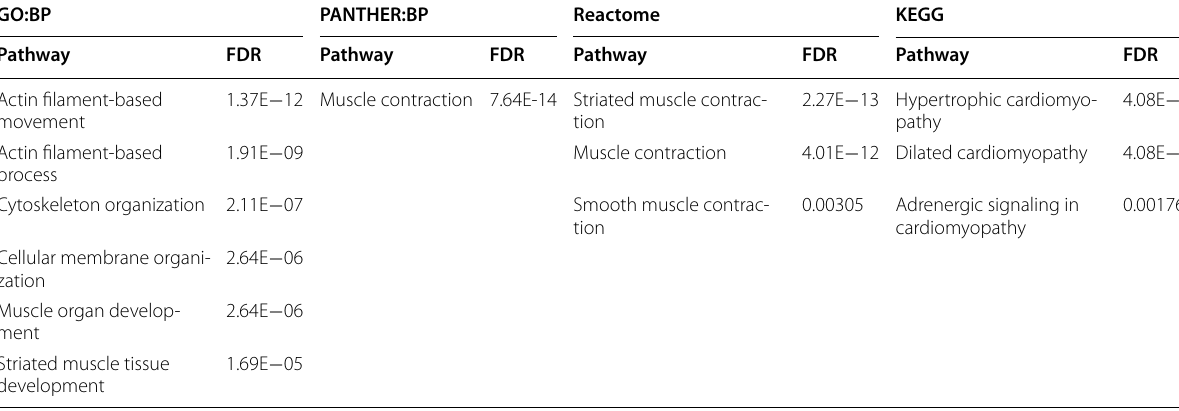
FDR false discovery rate